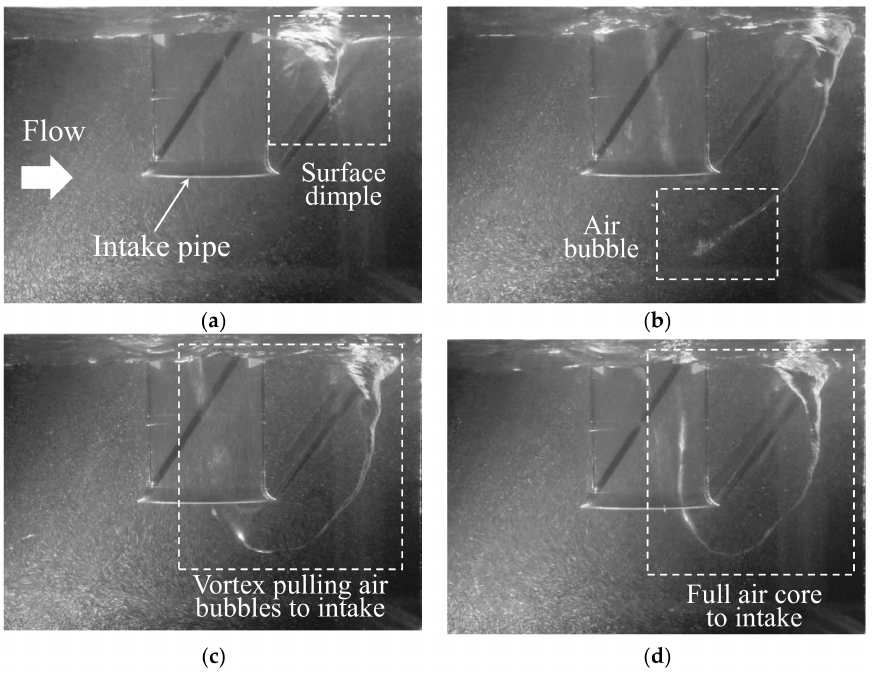
Figure 3. Air entrainment by the surface vortex: ( a ) surface dimple; ( b ) vortex pulling; ( c ) vortex pulling air bubbles to the intake pipe; and ( d ) full air core to the intake pipe.